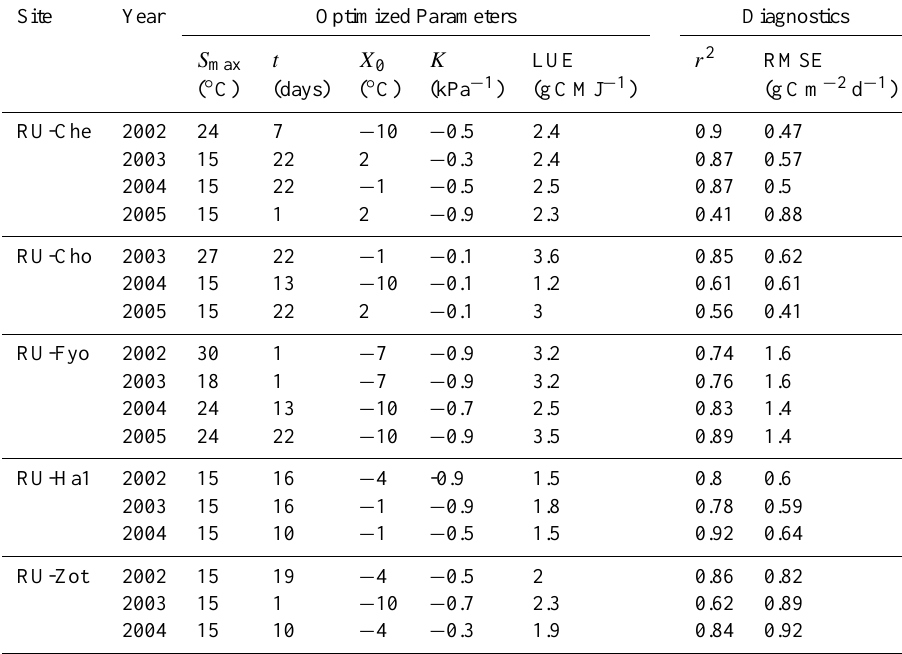
Table 4. Resulting optimized model parameters and regression diagnostics for the LUE-TA model by site and year. Site